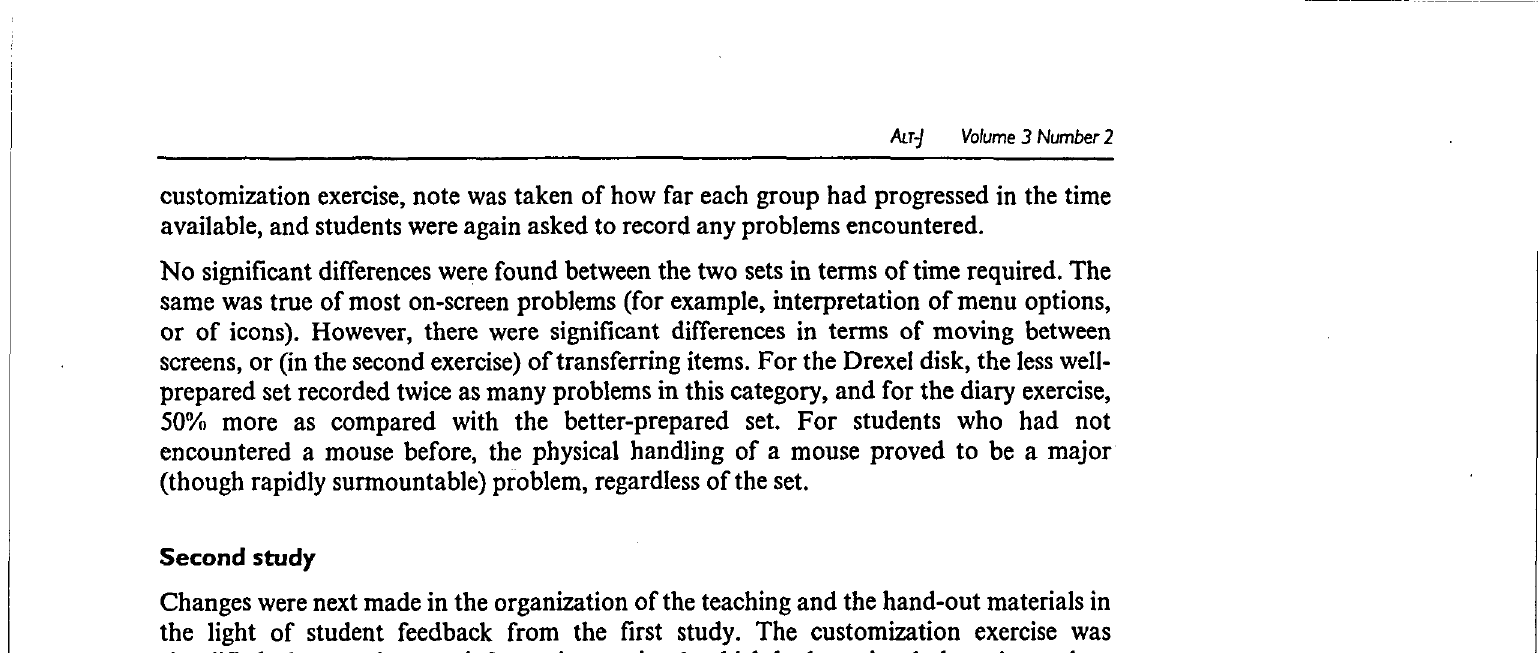
Table I: Groupings used in the second study